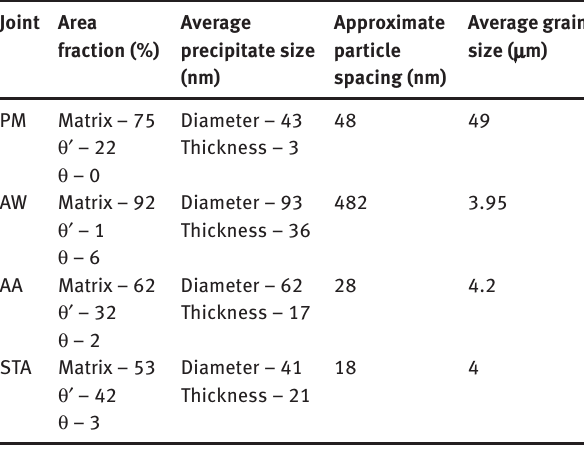
Table 3: Image analysis results of TEM and OM